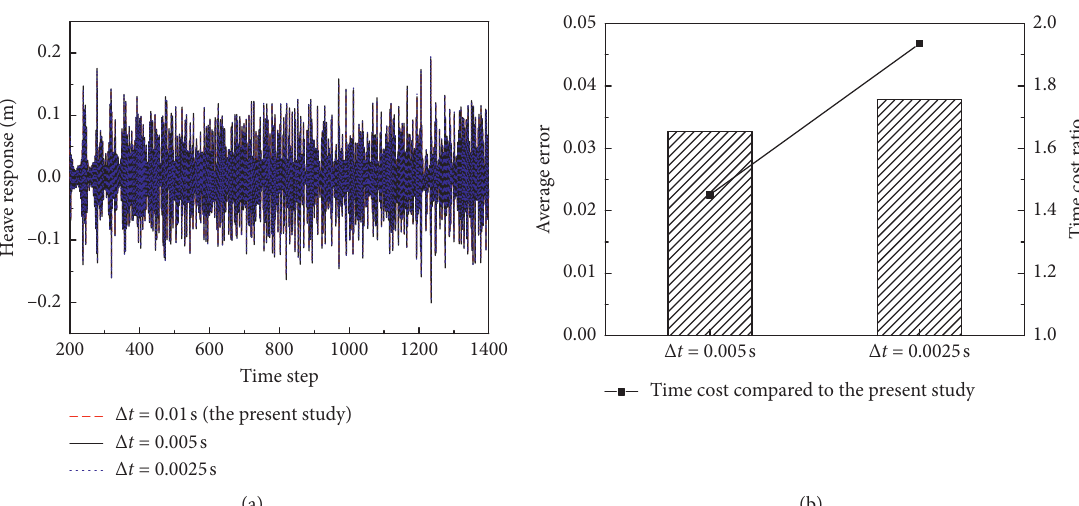
Figure 9: The heave response comparisons of different time steps: (a) the time series of heave displacement and (b) the average error and time cost ratio statistics compared to the present study. Table 8: RMS of heave response of different time steps. Case Δ t � 0 . 01 (present study) Δ t � 0 . 005 Δ t � 0 . 0025 Z